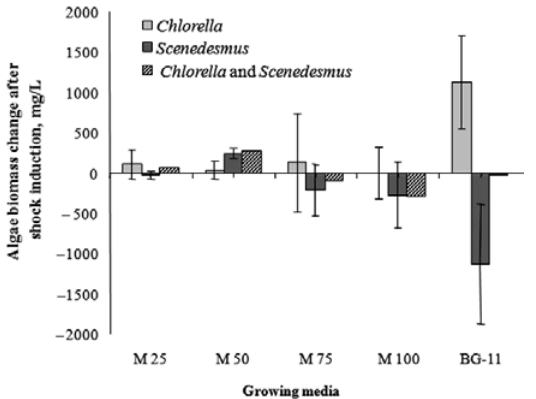
Fig. 8. Biomass yield of Chlorella and Scenedesmus species in wastewater at different concentrations after three days under nitrogen starvation